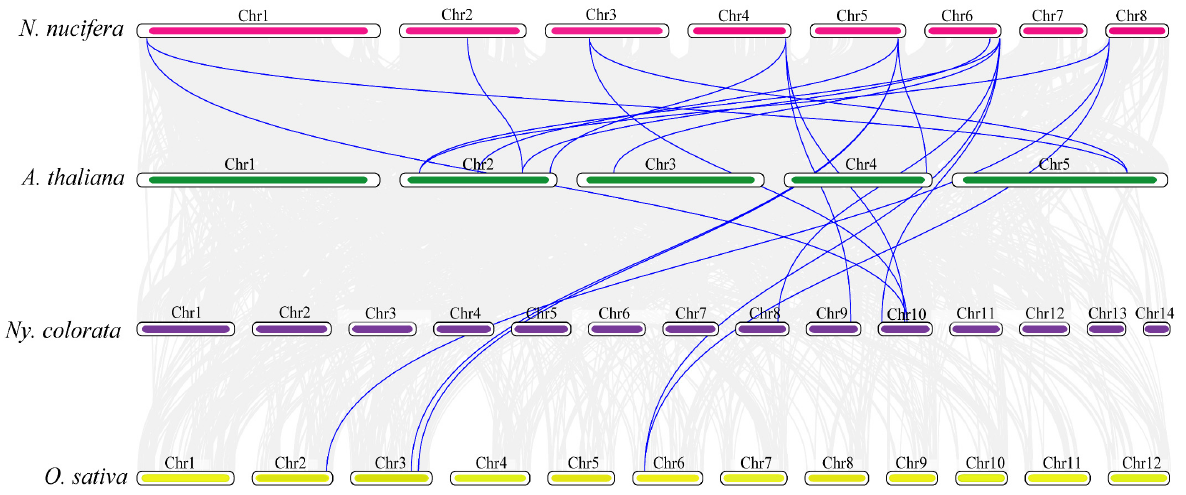
Figure 5. Synteny analysis of GRFs between N. nucifera , A. thaliana , O. sativa , and Ny. colorata . The gray lines in the background represent the colinear gene pairs in N. nucifera and other species; the blue lines represent the colinear GRF gene pairs .